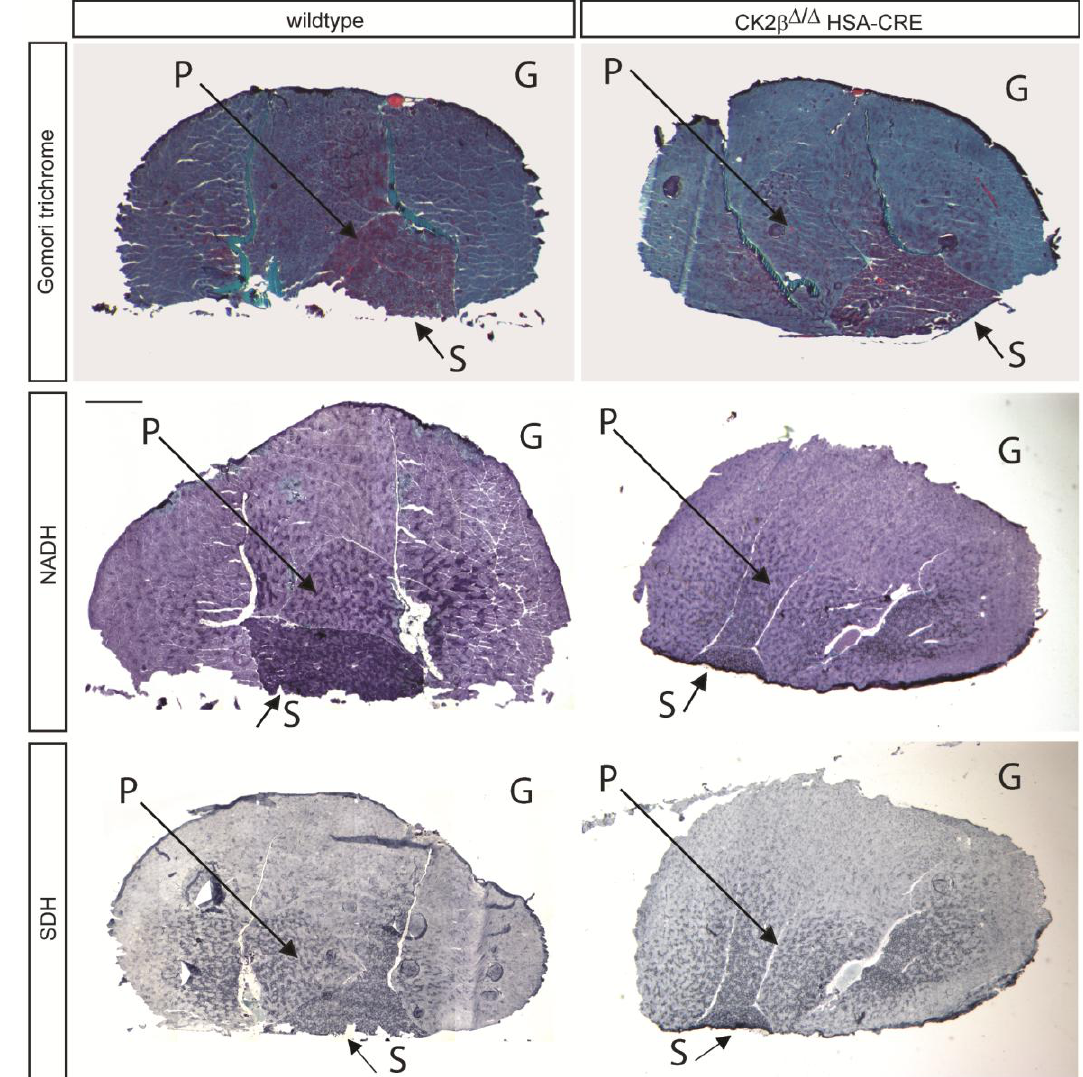
Figure 1. Typical images of full size hind limb cross sections after application of different types of histochemical stainings show gastrocnemius (G), plantaris (P), and soleus (S) of wildtype and CK2β-deficient (CK2 Δ/Δ HSA-Cre) muscles of mice. Histochemical stainings by Gomori trichrome and for detection of NADH dehydrogenase and SDH enzyme activities are indicated.